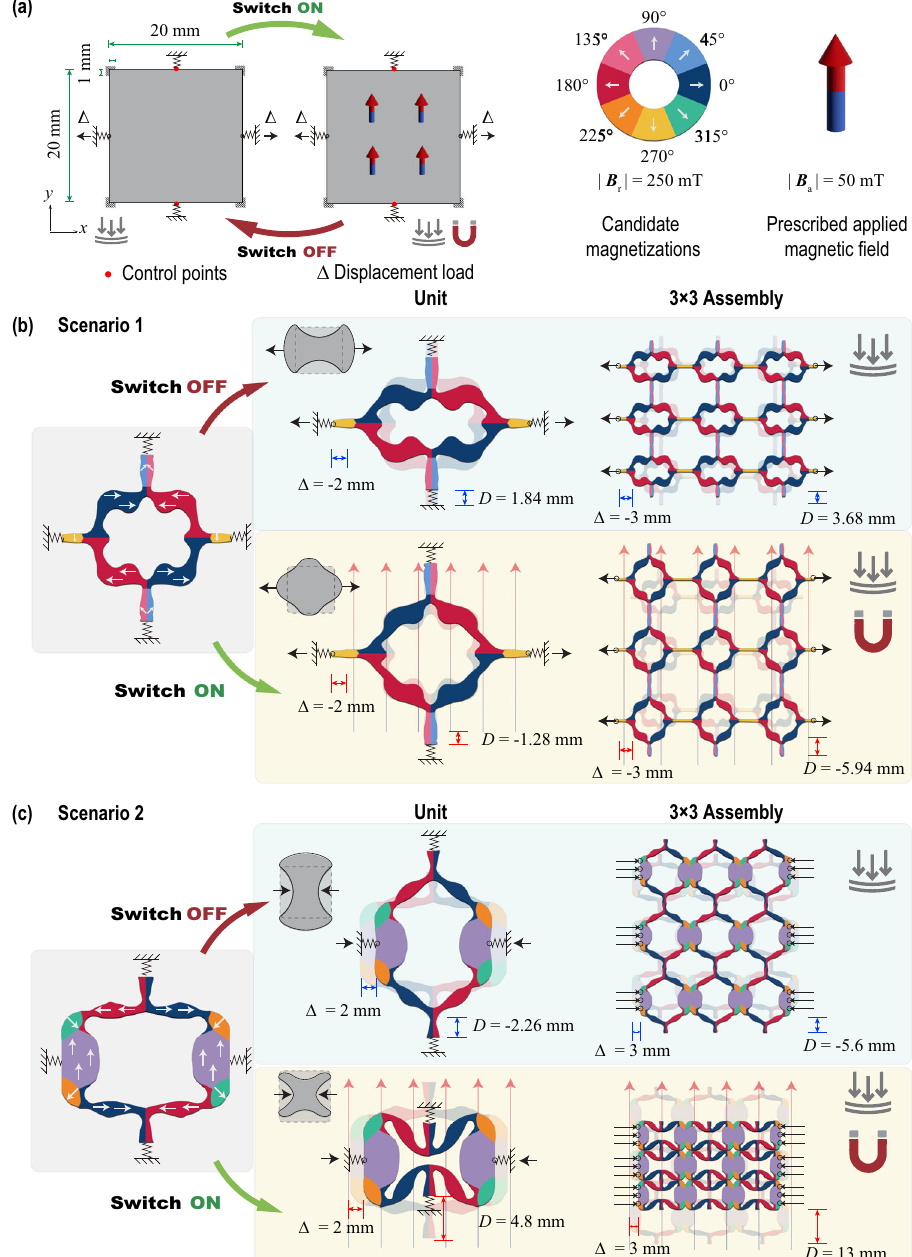
Fig. 4 Magneto-active metamaterial unit and assembly with reprogrammable deformation modes. a Design setup; b , c Two optimized units and their 3 × 3 assemblies under tensile and compressive mechanical loads, respectively. matrix material is modeled by the compressible Ogden model and simultaneous magneto-mechanical load cases, respectively. with initial Young ’ s modulus E = 0.25 MPa and Poisson ’ s ratio = 8 candidate magnetization ν = 0.499. We consider a total of N m vectors with uniform orientation space of 45 ∘ and the same magnitude of 250 mT. The applied magnetic fi eld B a is set as 50 mT pointing upward. The optimized designs under the two loading scenarios and their realized switchable deformation modes are presented in Fig. 4b, c, respectively. The volumes of the optimized designs for these two scenarios are set as 20% and 30% of the unit-cell volume, respectively. For Scenario 1, we apply a tensile displace- ment ( Δ = − 2 mm) horizontally and optimize the unit design to achieve two distinct deformation modes under purely mechanical npj Computational Materials (2023)